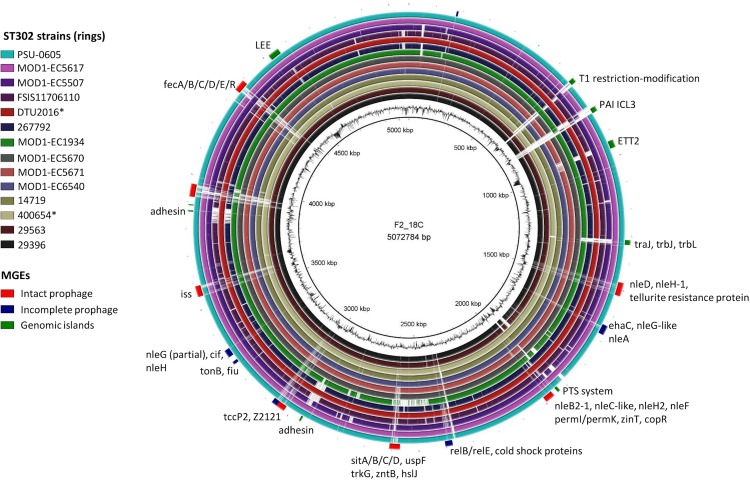
BRIG diagram of MGE distribution in the F2_18C chromosome compared to other ST302 strains. Along the periphery, intact prophages are shown in red, incomplete prophages in navy and GIs in green. Some notable genes present in these regions are labeled accordingly. ∗Indicates an abbreviated strain name: 400654∗ = Escherichia_coli_400654-sc-2012-01-13T20:11:31Z-1332520; DTU2016∗ = DTU2016_526_ PRJ1050_ Escherichia _coli_Isol133.